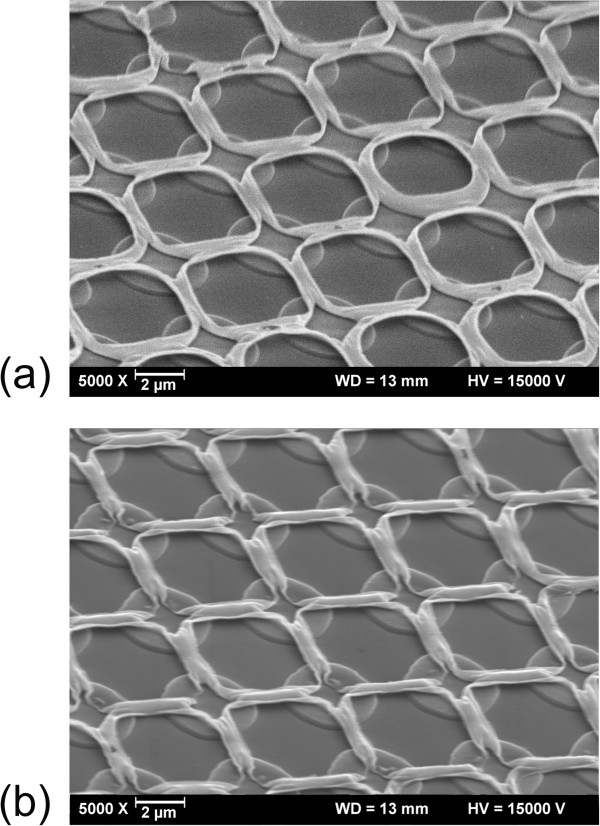
Pattern before and after annealing. Grid pattern generated in a 90-nm-thick SiOx film at 248-nm laser wavelength: (a) 185 mJ/cm2, before annealing; (b) 210 mJ/cm2, after oxidation to SiO2 by high-temperature annealing (1,273 K, 16 h).